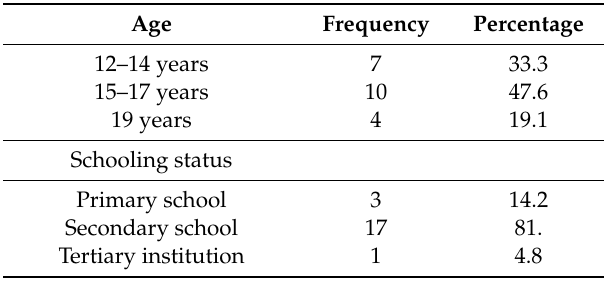
Table 1. Demographic characteristics of the